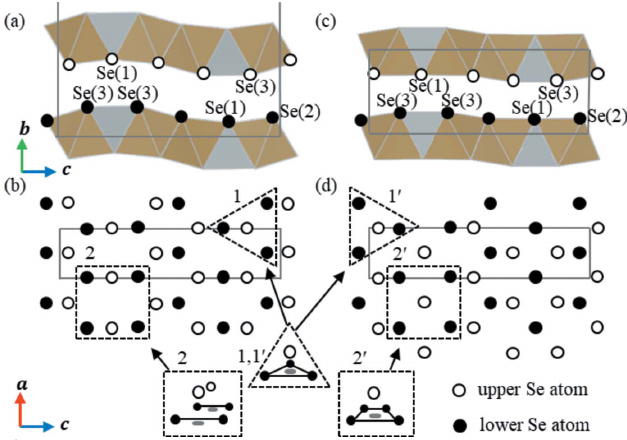
Figure 4 ( a ) and ( b ) Schematic representations of the arrangement of interlayer selenium atoms <3 GPa, viewed from the a and b axes, respectively. ( c ) and ( d ) As for panels ( a ) and ( b ) but at pressures >3 GPa. In panels ( a ) and ( c ) Se(1)–Se(3) represent three different crystallographic sites. Empty and filled circles indicate the upper- and lower-layer Se ions, respectively. Solid lines represent the size and shape of the unit cell. Sites 1 and 2 represent stable and unstable phase II sites, respectively, while sites 1 0 and 2 0 represent stable phase III sites under high pressure following phase transition.